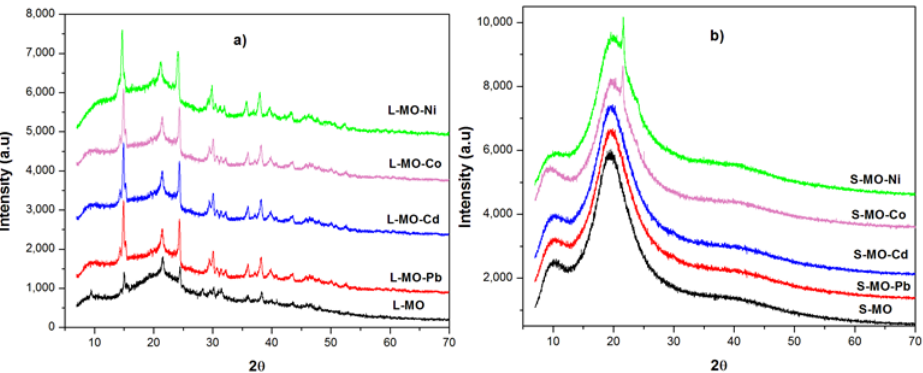
Figure 2. XRD patterns of ( a ) L-MO, L-MO-Pb, L-MO-Cd, L-MO-Co, and L-MO-Ni; and ( b ) S-MO, S-MO-Pb, S-MO-Cd, S-MO-Co, and S-MO-Ni.